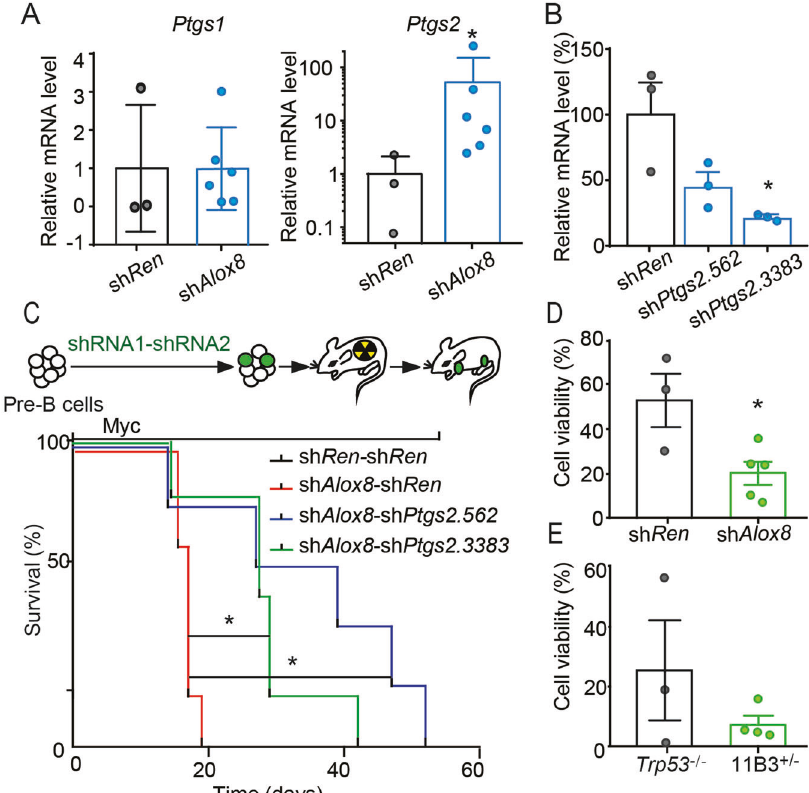
Fig. 3 Ptgs2 was upregulated in Alox8 -de fi cient lymphomas, which contributed to lymphomagenesis. A Relative mRNA levels of Ptgs1(Cox- 1) and Ptgs2(Cox-2) in sh Ren or sh Alox8 lymphoma cells, measured by RT-qPCR. n = 3 for sh Ren group and n = 6 for sh Alox8 group. * p < 0.05 (un p aired two-tailed t -test). B Knockdown ef fi ciency of Ptgs2 by sh Ptgs2 .562 and sh Ptgs2 .3383 in sh Trp53 lymphoma cells, measured by RT- qPCR. n = 3. Error bar represents “ Mean with SEM ” , * p < 0.05 (unpaired two-tailed t -test). C Kaplan – Meier tumor-free survival of recipient mice transplanted with tandem shRNAs for both Alox8 and Ptgs2 . n = 6. * p < 0.05 (log-rank test). D Relative cell counts of Myc ; sh Trp53 -sh Ren (sh Ren ) or Myc ; sh Trp53 -sh Alox8 (sh Alox8 ) lymphoma cells treated with 50 μ M celecoxib or vehicle for 48 h. n = 3 for sh Ren group and n = 5 for sh Alox8 group. Error bar represents “ Mean with SEM ” , * p < 0.05 (unpaired two-tailed t- test). E Relative cell counts of Trp53 -/- or 11B3 + /- lymphoma cells treated with 50 μ M celecoxib or vehicle for 48 h. n = 3 for sh Ren group and n = 4 for sh Alox8